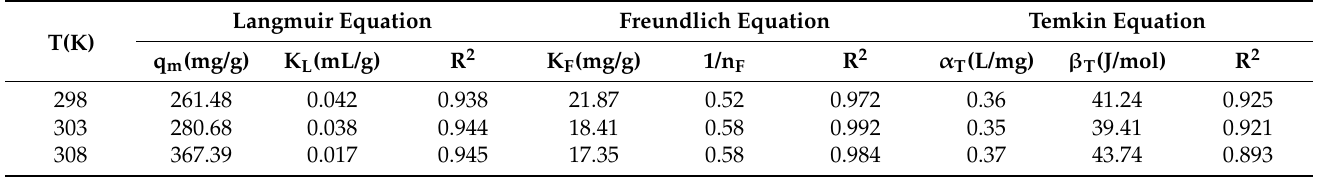
Figure 16. Langmuir, Freundlich, and Temkin isotherm model of MDG on adsorption of MG solution at ( a ) 298K, ( b ) 303K and ( c ) 308K. Table 4. Langmuir, Freundlich, and Temkin adsorption isotherm model parameters.